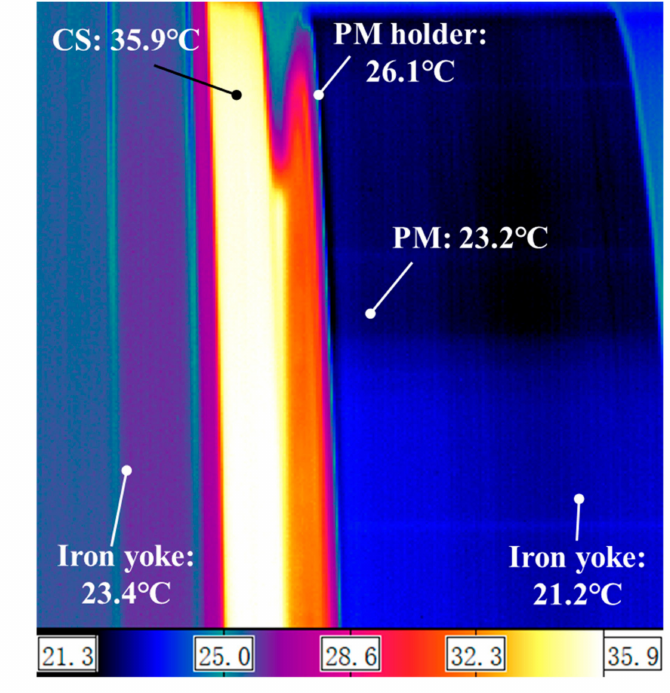
Figure 16. Temperature measurement results obtained by thermal camera ( l g = 5 mm and s = 20 r /